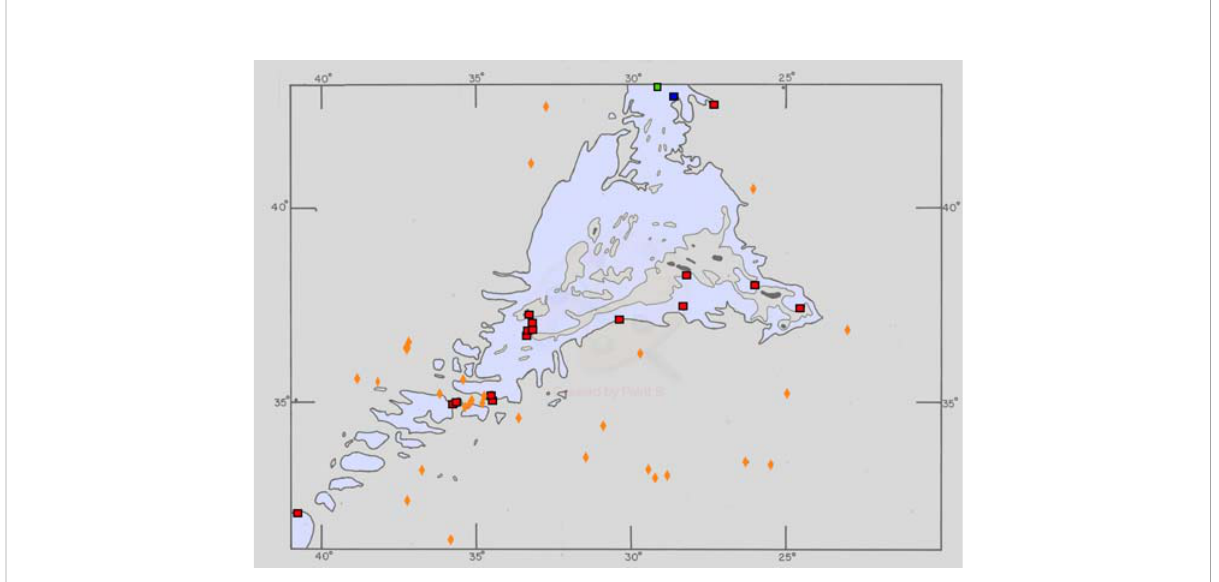
FIGURE 1 Location of stations fi nding the rows of holes. Tinted area is depths between 1,500 and 2,500 meters. Red squares are camera stations reported by Hinga, 1981. Blue square is location reported in Vecchoine and Bergstad (2022). Green square is location of Dive 4 of Voyage to the Ridge. The station reported by Bell et al (2013) is signi fi cantly further north at aprox. 49°N and 28°47´ W. Orange diamonds are camera stations where the rows of linear holes were not found in the region by Hinga